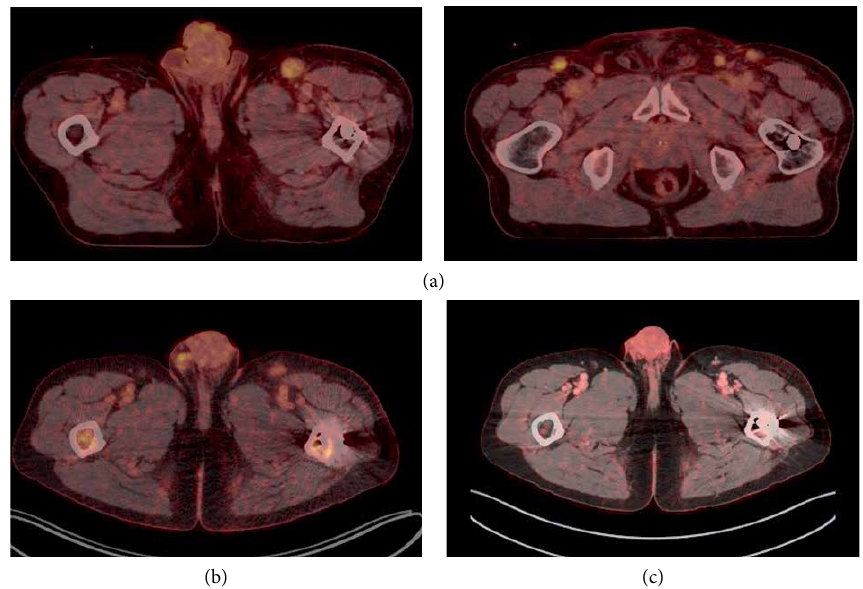
Figure 1: (a) PET-CT at baseline showing an enlarged lymph node in the left and right groin measuring 2.7 × 1.9 cm and 1.4 × 1.6 cm, respectively, with increased metabolic activity. Enlarged and hypermetabolic lymph nodes were also found in the mediastinum and the left side of the retroperitoneum. (b) PET-CT after course 10 showing lymph nodes in the left groin with normal size and metabolic activity. Rest of the PET-CT showed complete remission of other tumour sites. (c) PET-CT after 15 months at follow up with no signs of